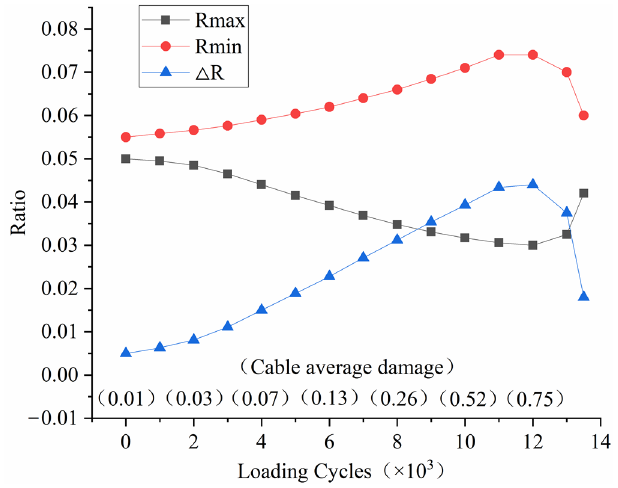
Figure 6. Curve of the e ff ective bearing area ratio of steel wire with loading times.